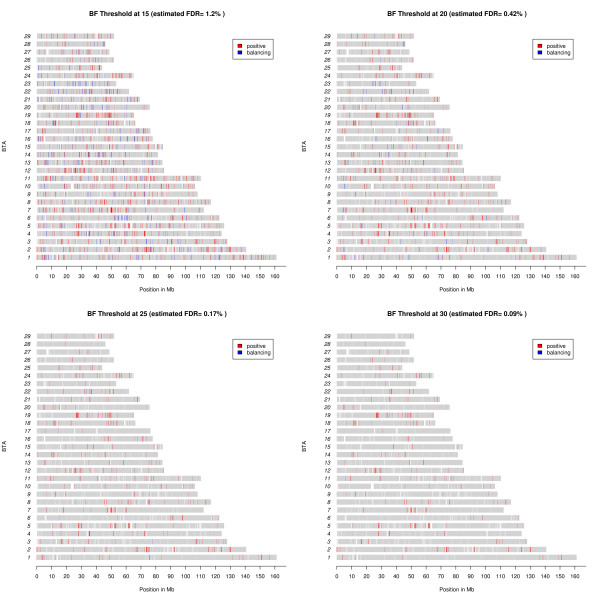
Genome position of the locus declared under selection. For each BF thresholds, the color indicates whether the SNP is neutral (grey), under positive selection (red) or balancing selection (blue). The type of selection (balancing or positive) is deduced from the SNP FST value (< 0.1 or > 0.1).